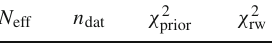
for the case of the inclusion of the LHCb data on R fb to the prior fit by means of